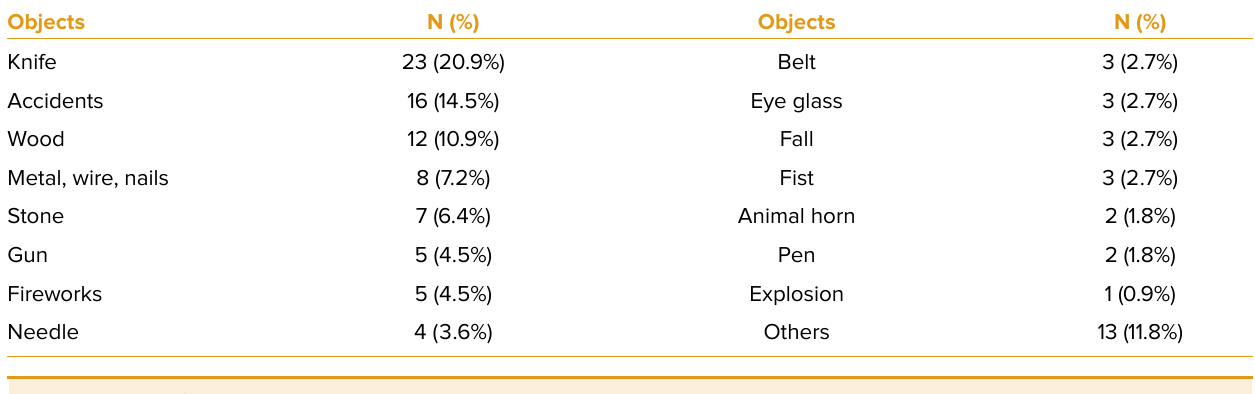
Table 3. Causative objects of open globe injuries in children. Objects N (%) Objects